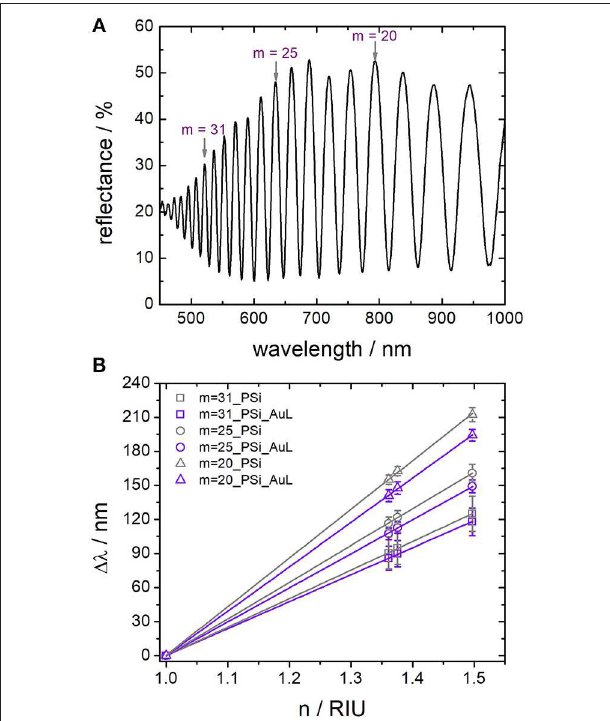
FIGURE 5 | (A) Effective optical thickness of sensors in air calculated by applying a fast Fourier transform to appropriately prepared reflectance spectra. (B) Sensitivity of sensors determined by using shifts in the EOT in response to changing the refractive index of the immersion medium.